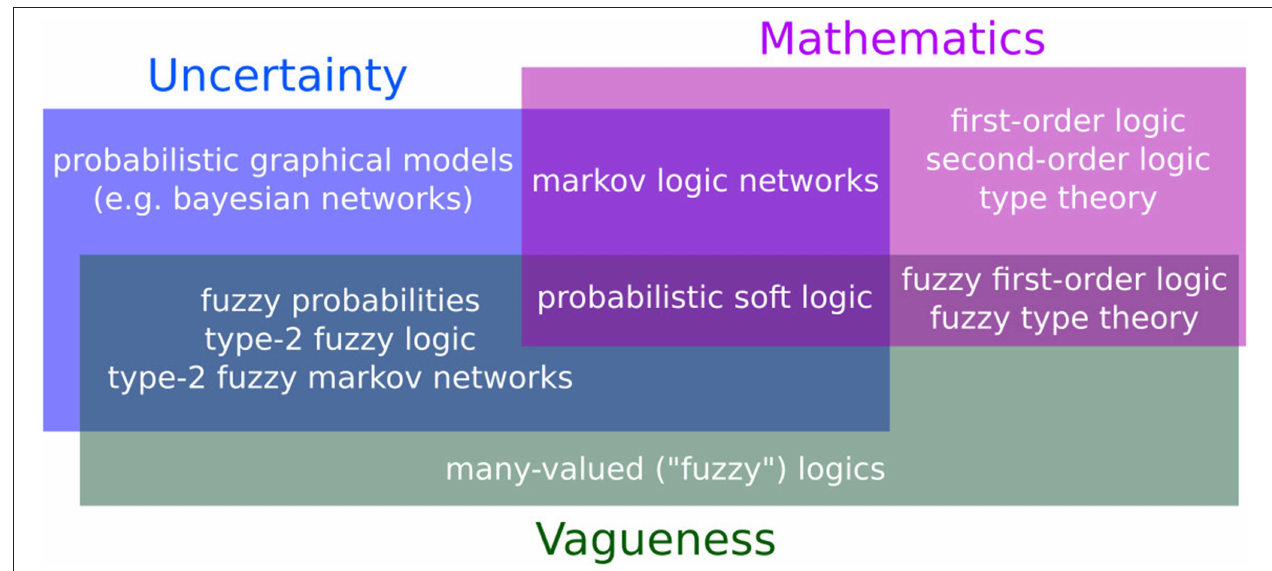
FIGURE 2 | Various languages and their ability to model uncertainty, vagueness, and mathematics (the size of the rectangles has no meaning). In the blue rectangle: languages capable of handling uncertainty. Probabilistic graphical models combine probability theory with graph theory to represent complex distributions (Koller and Friedman, 2009 ). Alternatives to probability theory for reasoning about uncertainty include possibility theory and Dempster-Shafer belief functions, see Halpern (2003) for an extended discussion. In the green rectangle: Fuzzy logic extends standard logic by allowing truth values to be anywhere in the [0,1] interval. Fuzziness models vagueness and is particularly popular in linguistics, engineering, and bioinformatics, where complex concepts and measures tend to be vague by nature. See Kosko (1990) for a detailed comparison of probability and fuzziness. In the purple rectangle: languages capable of modeling mathematical formulas. It is important to note that while first-order logic is expressive enough to express a large class of mathematical ideas, many languages rely on a restricted from of first-order logic without functions. Alone, these languages are not powerful enough to express scientific ideas, we must thus focus on what lies at their intersection. Type-2 Fuzzy Logic is a fast-expanding (Sadeghian et al., 2014; Mendel, 2017) extension to fuzzy logic, which, in a nutshell, models uncertainty by considering the truth value itself to be fuzzy (Mendel and Bob John, 2002; Zeng and Liu, 2008). Markov logic networks (Richardson and Domingos, 2006; Domingos and Lowd, 2009) extends predicate logic with weights to unify probability theory with logic. Probabilistic soft logic ( Kimmig et al., 2012; Bach et al., 2015) also has formulas with weights, but allows the predicates to be fuzzy, i.e., have truth values in the [0,1] interval. Some recent deep learning studies also combine all three aspects (Garnelo et al., 2016; Hu et al., 2016).